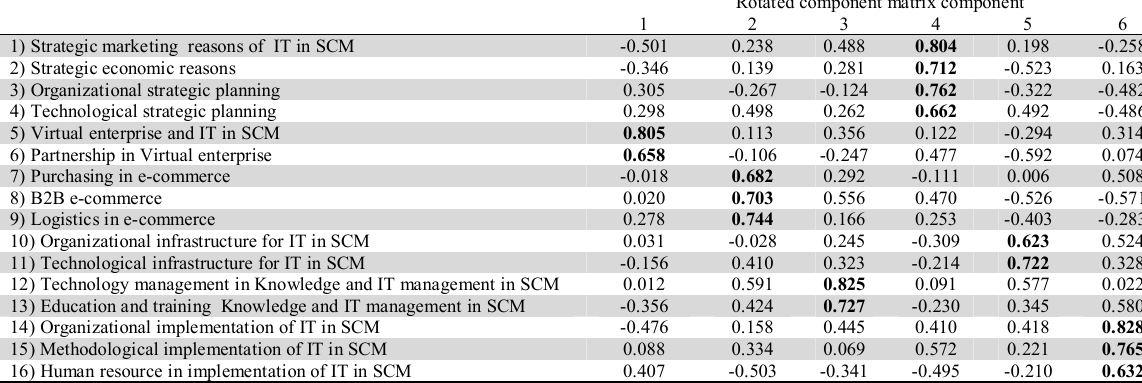
Final statistics in rotated component matrix